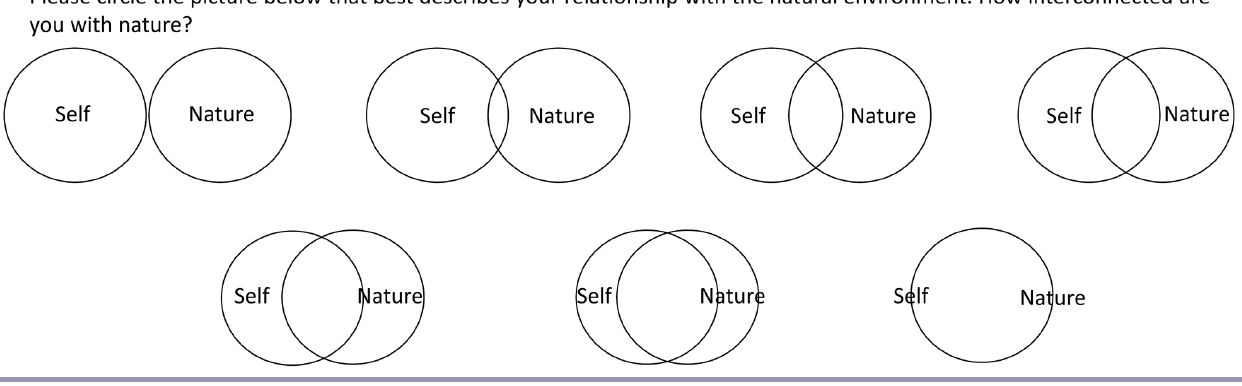
Fig. 2 . Inclusion-of-nature-in-self scale (reproduced from Schultz